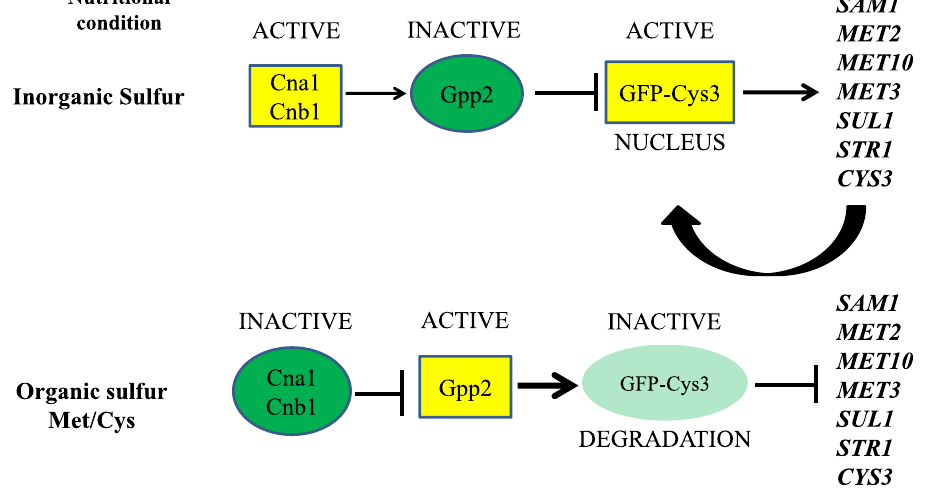
Figure 8. Model of the sulfur amino acids biosynthesis regulation in C . neoformans